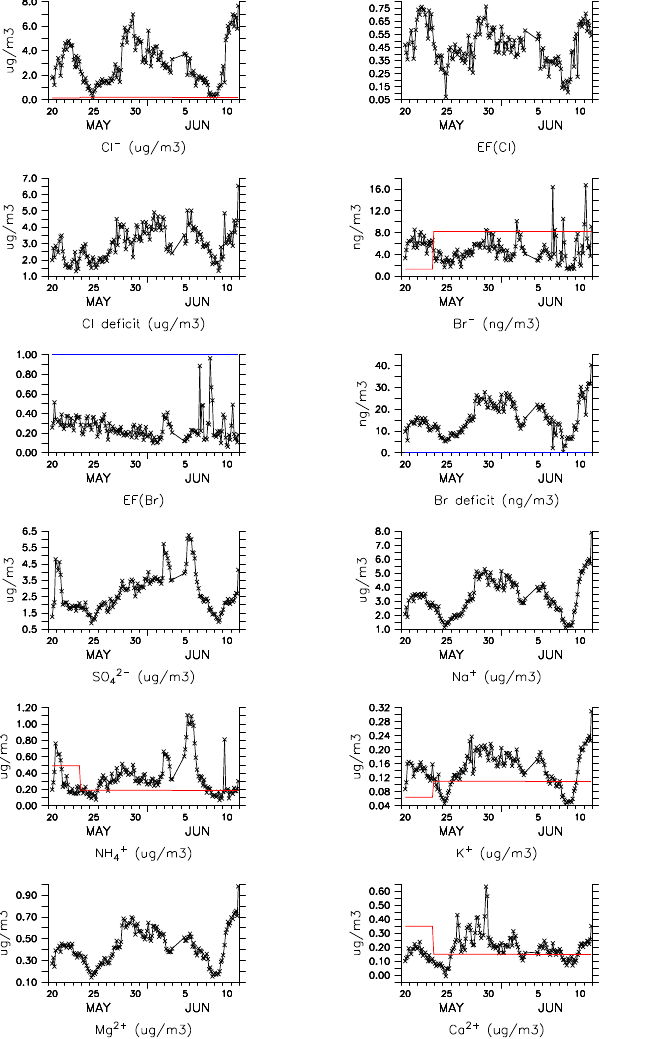
Figure 7. Time series of the filter pack data, analyzed by IC. The blue lines denote sea water composition, i.e., EF = 1 and deficit = 0. The red lines denote the detection limit. The di ff erent detection lim- its reflect di ff erent blank mean amounts and variances in filters used during early vs. later portions of the campaign.